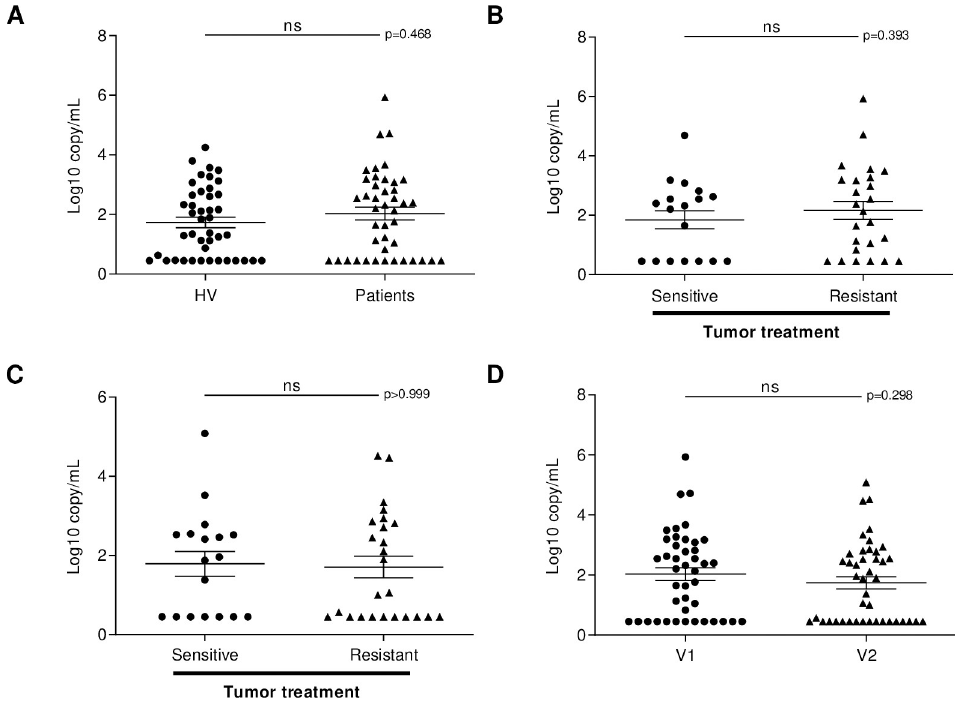
Fig 1. Comparison of TTV viral load in healthy volunteers and melanoma patients before and after 6 months of anti-PD-1 therapy. (A) Torque Teno Virus (TTV) viral load of healthy volunteers (HV) and melanoma patients prior to the initiation of anti-PD-1 therapy (V1). (B) and (C) TTV viral load in the treatment-sensitive tumor and treatment- resistant tumor groups of melanoma patients B) before (V1) and C) 6 months after (V2) the initiation of anti-PD-1 therapy. (D) TTV viral load of the melanoma patients prior to the initiation of anti-PD-1 therapy (V1) and after 6 months of anti-PD-1 therapy (V2). A viral load of 0.45 log 10 copy/mL as assigned to patients and controls with undetectable viral load which is the lowest limit of detection. ns: